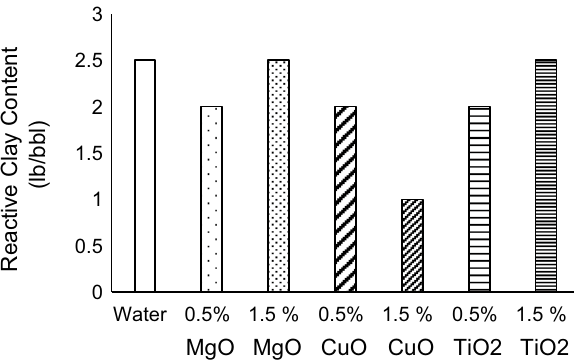
Table 4 The result of CEC test Fluid type NP concentra-